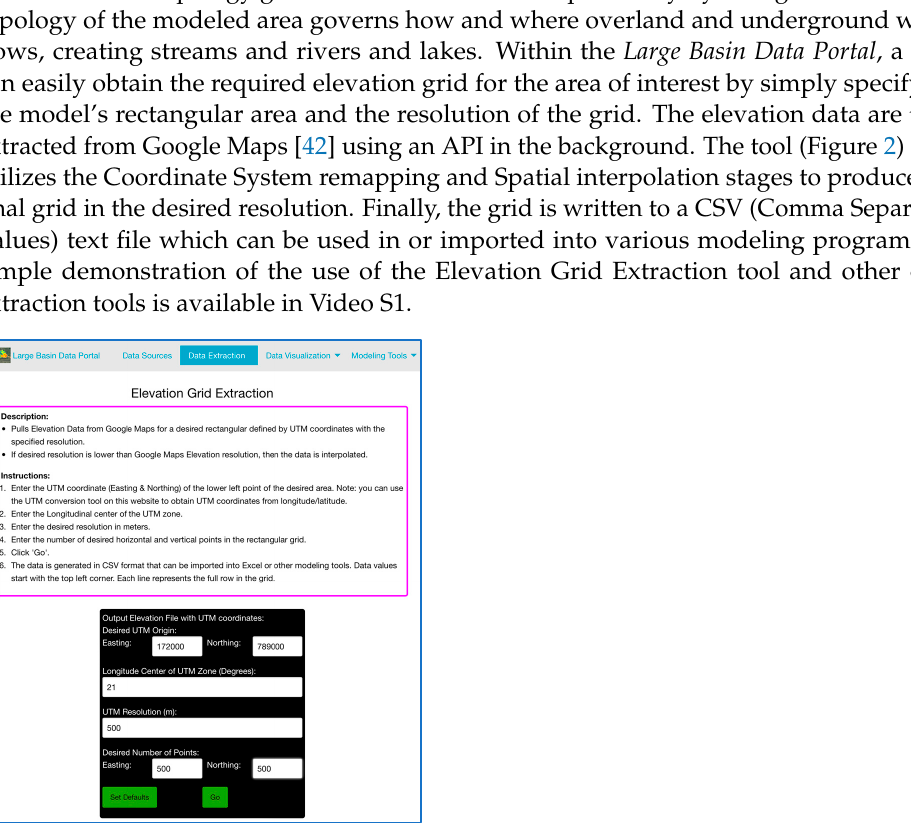
Figure 2. Screenshot of the Large Basin Data Portal elevation extraction tool with description, usage instructions, and input parameters.